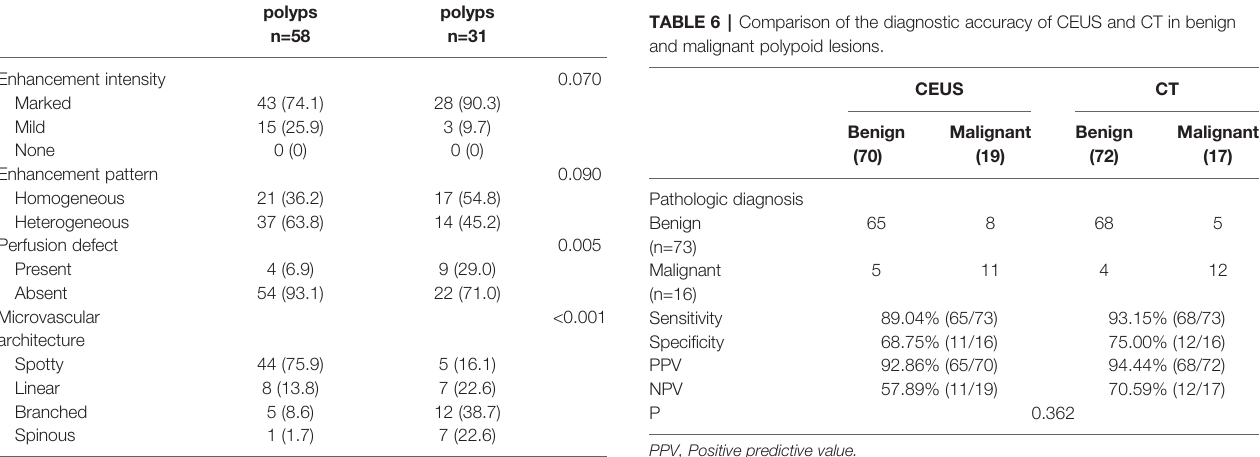
TABLE 4 | CEUS features of neoplastic and non-neoplastic polypoid lesions. Features